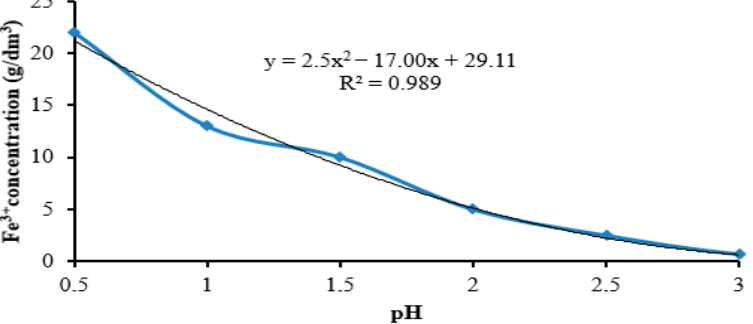
Figure 12. Dependence of Fe(III) content in solution on the pH.